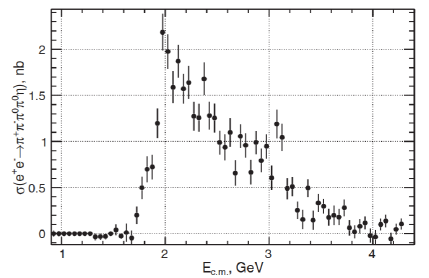
Figure 4. The measured e + e − → π + π − η cross section fitted with the four models described in the